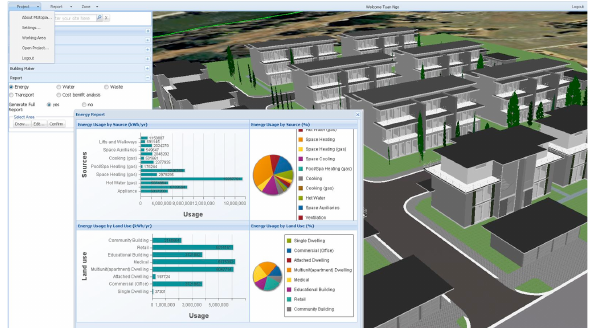
Figure 8: Prototype mesh rendering and reporting with